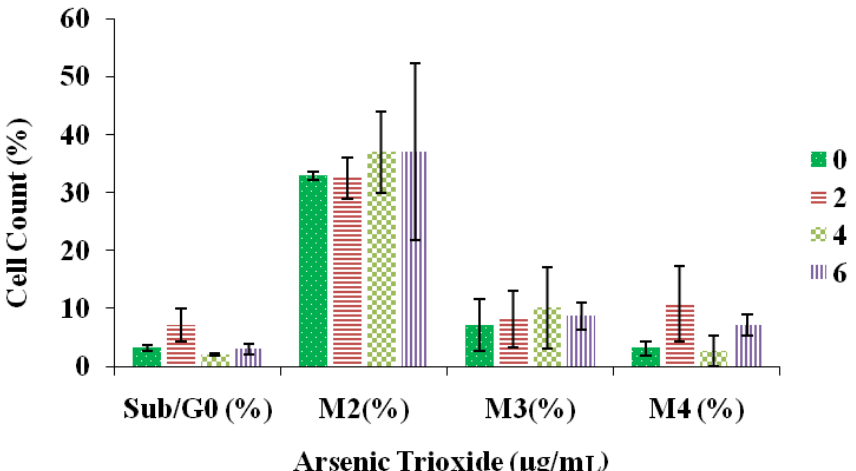
Figure 5. Effect of arsenic trioxide on cell cycle distribution in A549